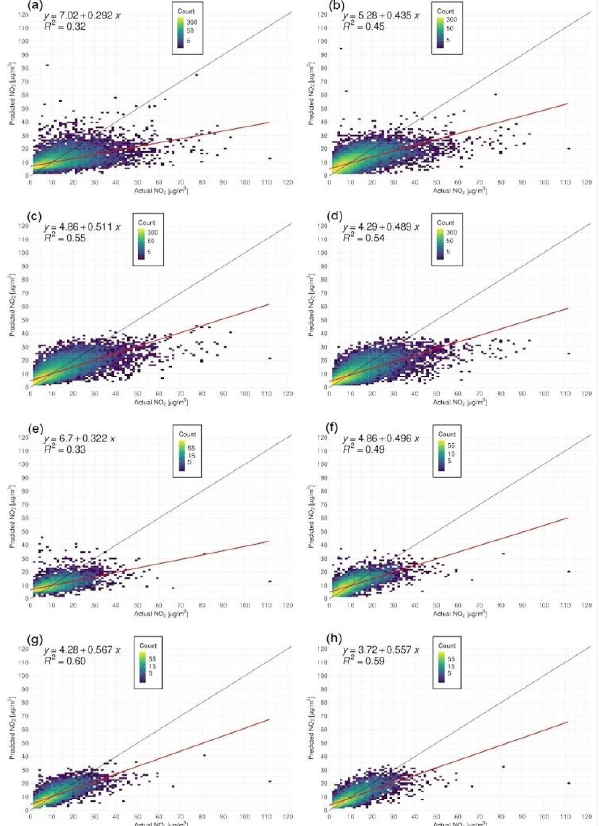
Figure 3. Binned scatter plots showing the distribution of predicted vs. actual (ground-based observations) NO 2 mass concentrations: ( a – d ) hourly measurements; ( e – h ) weekly averages. The black line shows a perfect agreement, while the red line is according to the predicted values vs. the actual values: ( a , e ) LM-S5P; ( b , f ) MLM; ( c , g ) RF; ( d , h ) RF. The count is the frequency of actual NO 2 values expressed using a logarithmic